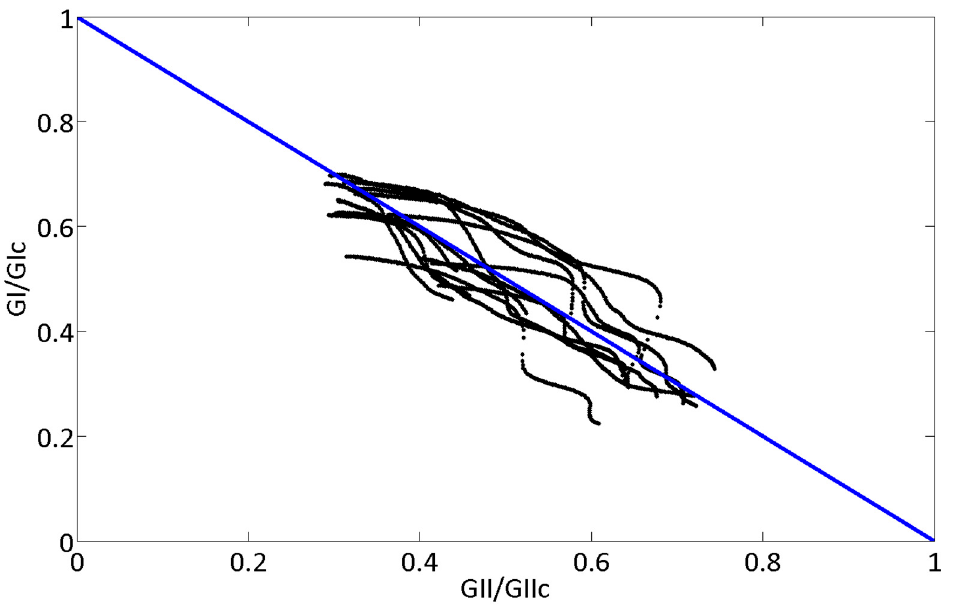
Figure 9. Fracture envelope.